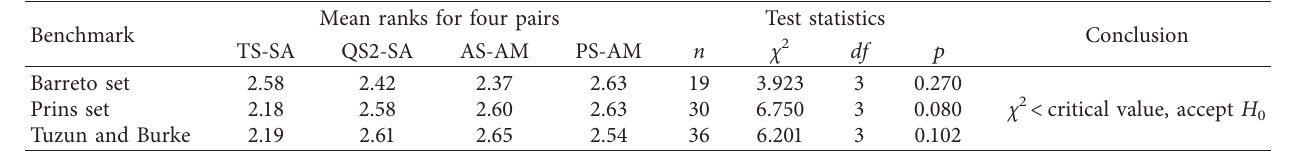
Table 7: Friedman’s test results for CLRP benchmark instances ( α �